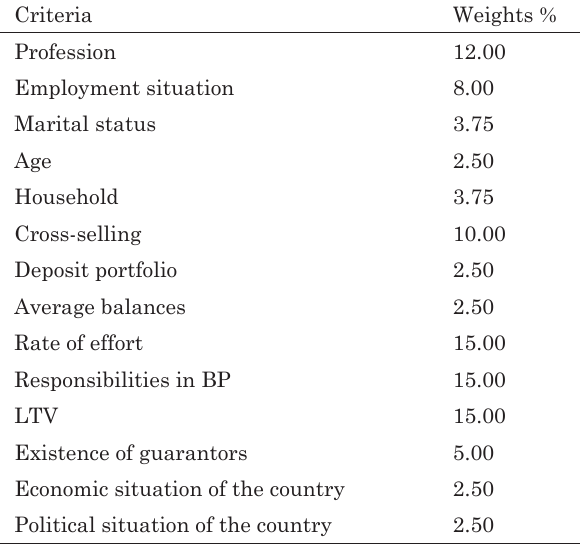
Table 1. Criteria and respective